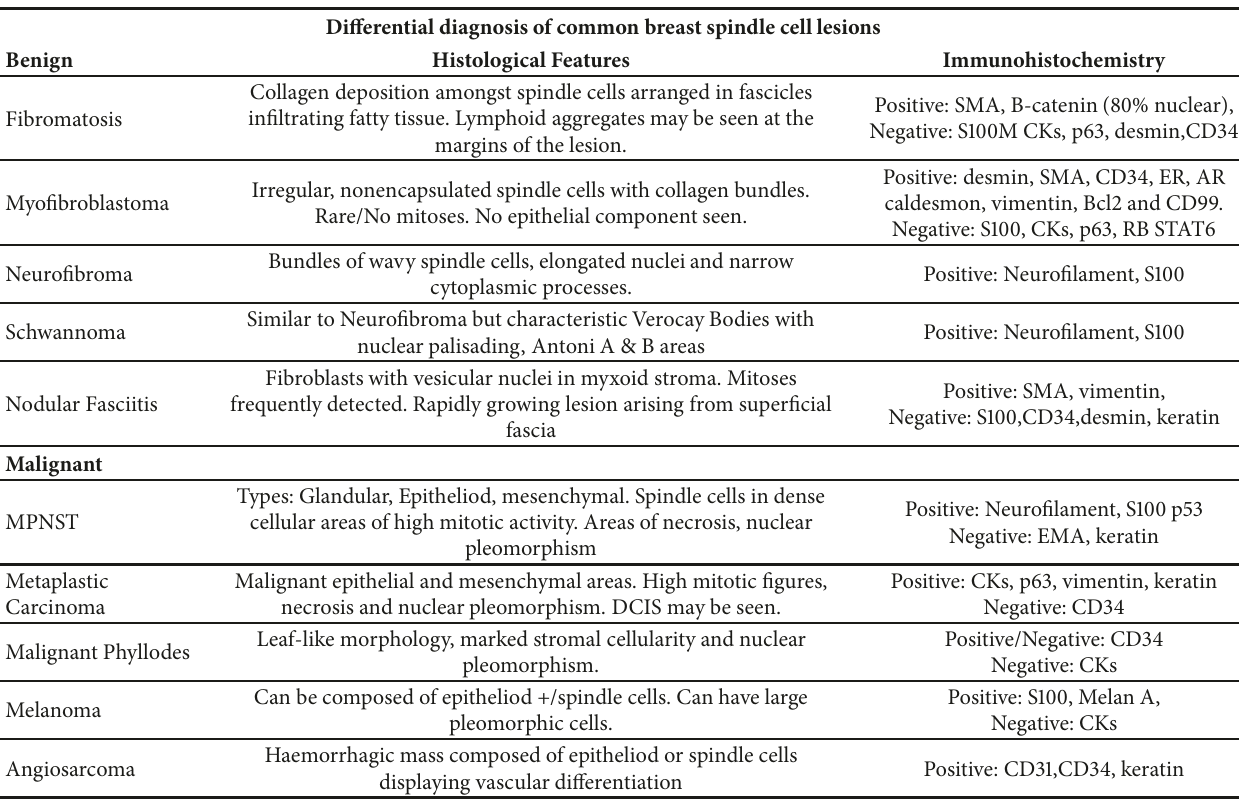
Table 1: Differential diagnosis of common breast spindle cell lesions that may involve the nipple [3–5]. SMA: smooth muscle actin, ER: estrogen receptor, PR: progesterone receptor, DCIS: ductal carcinoma in situ, and CKs: